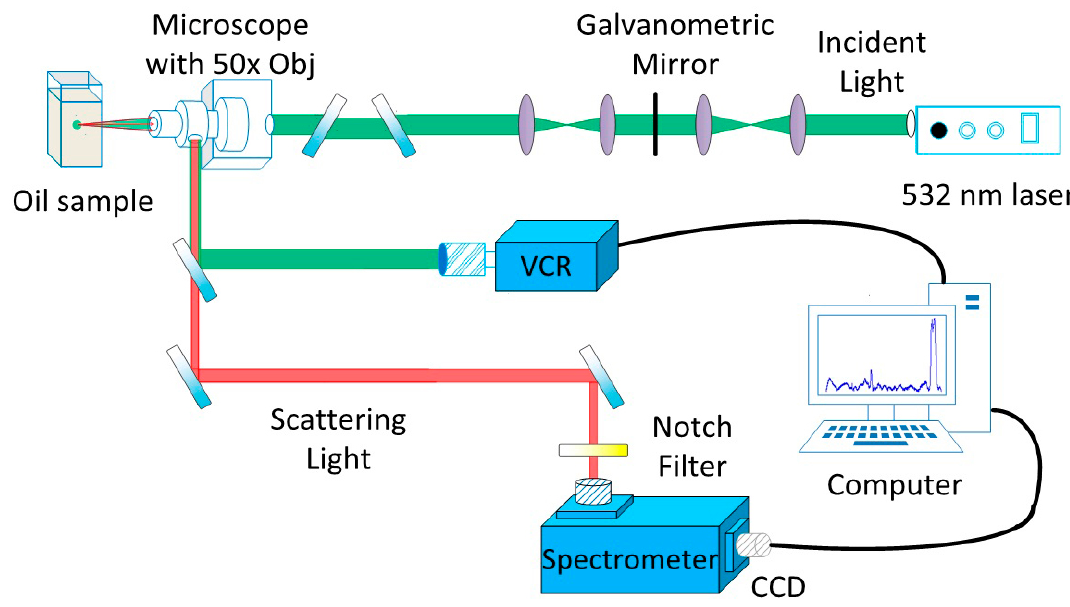
Figure 1. Schematic diagram of the CLRS liquid detection test platform.